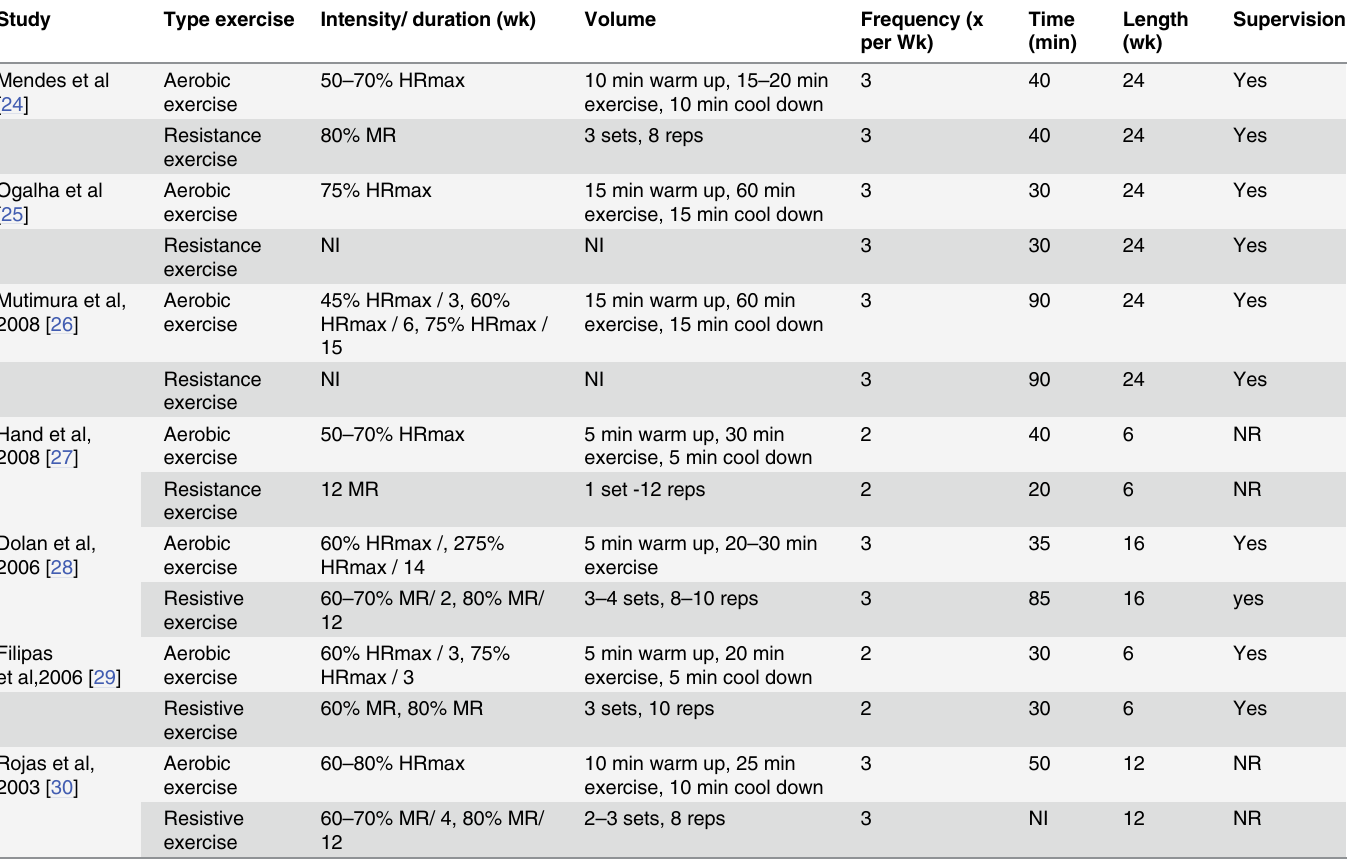
Table 4. Characteristics of the CARE Intervention in the Trials Included in the